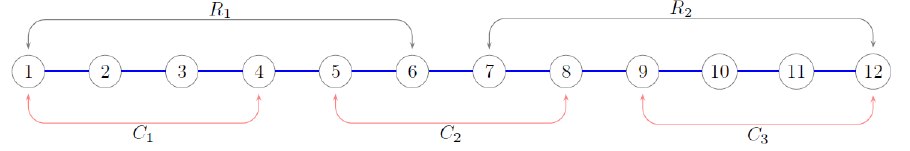
Figure 4. Chain Ch = ( N , E ) of 12